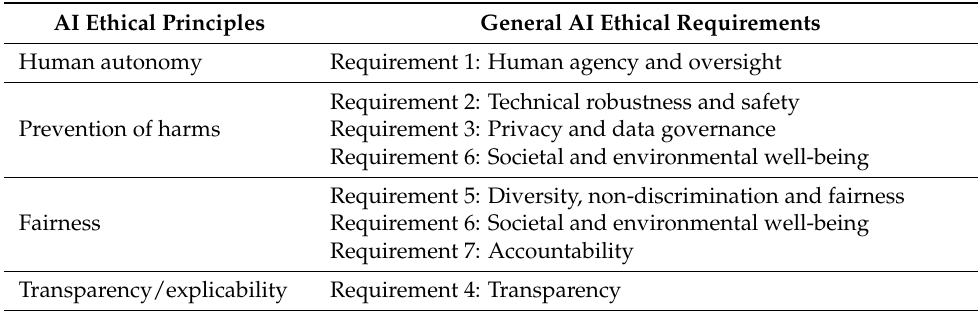
Table 1. AI ethical principles and the respective general AI ethical